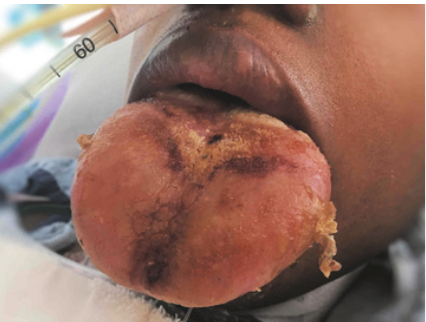
Figure 1: Lingual edema prior to initiation of lingual compression therapy. Note patient extubated with tracheostomy (not visible).